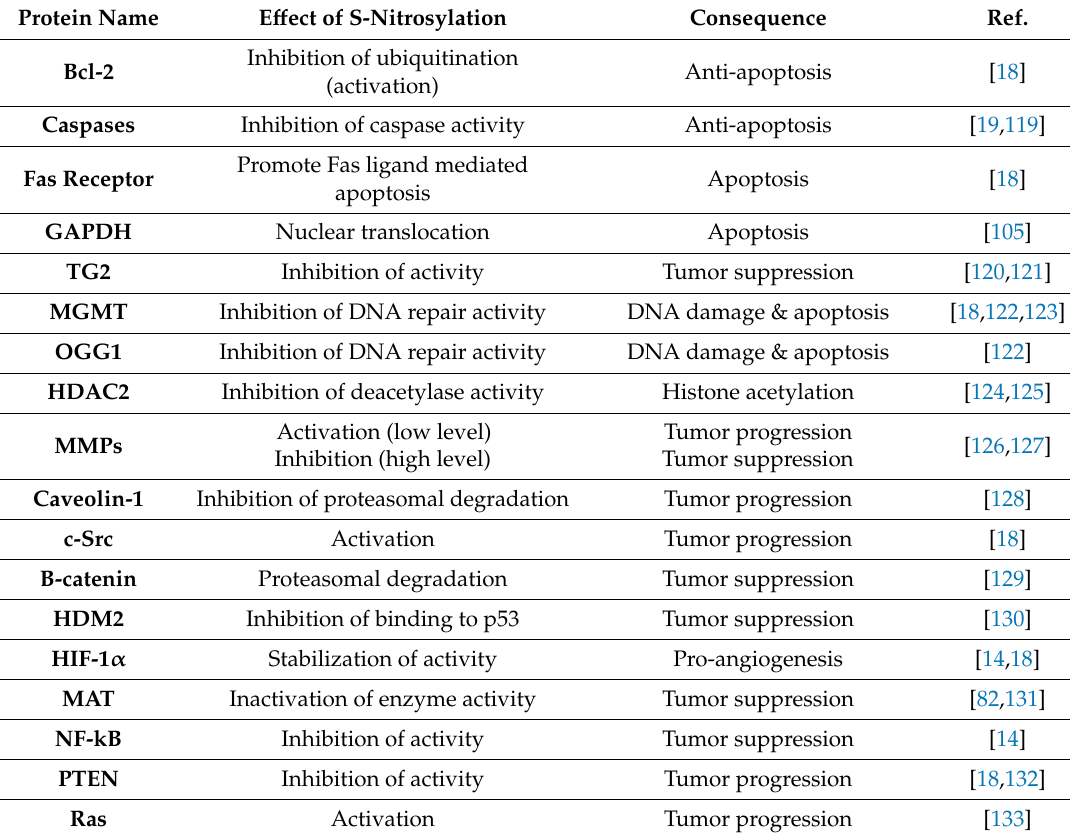
Table 1. E ff ect of S-nitrosylation of proteins associated with Tumor